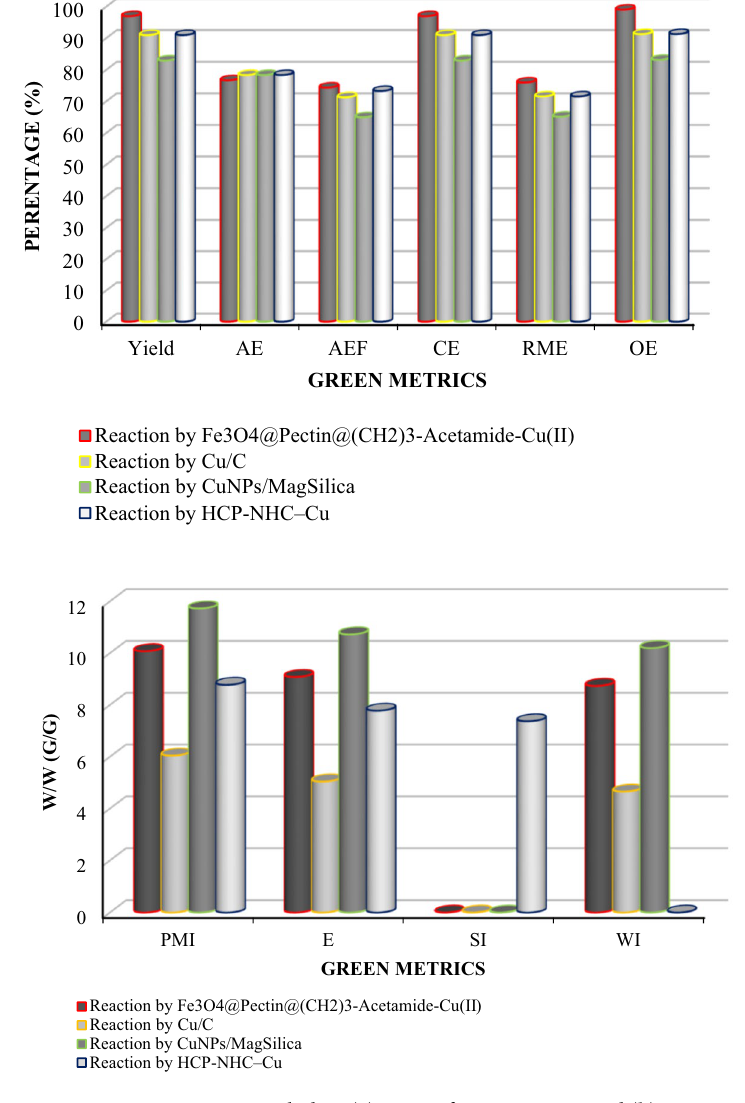
(Table 3, entries 1, 4 and 6), the current catalyst’s green metrics was compared with those of three previously reported catalysts. As it is shown in Figs. 13 and 14, the high values of the AE, AEF, CE, RME, and OE for the synthesis of 1-benzyl-4-phenyl-1H-1,2,3-triazole and 1-Phenyl-2-(4-phenyl-1H-1,2,3-triazol-1-yl)ethanone, shows well the greenness of the process. The lower the PMI, E, and SI, the more favorable process is because of green chemistry 101–114 .